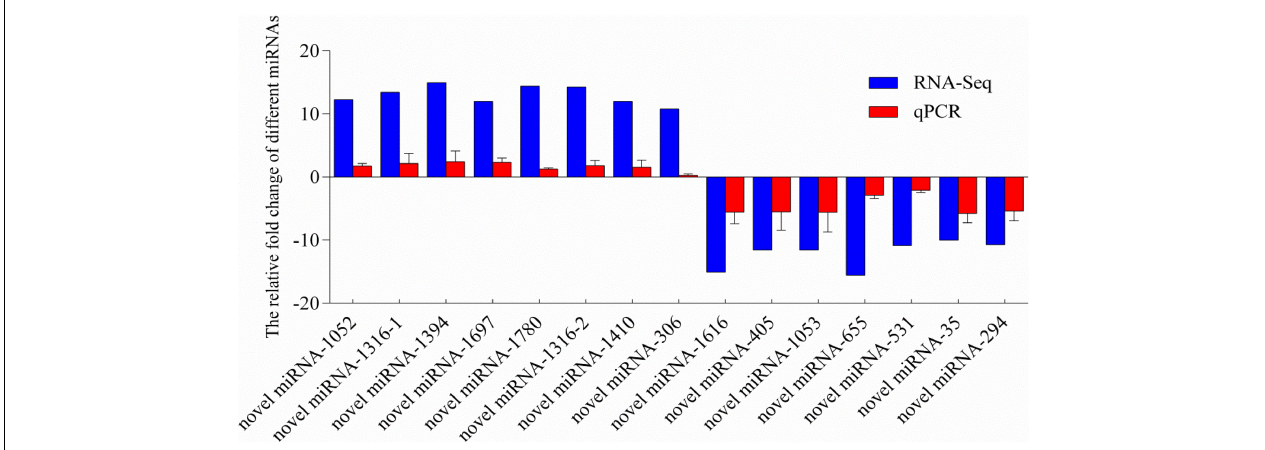
FIGURE 4 | Relative fold change of different miRNAs between qPCR and miRNA-sequencing results. MicroRNA expression levels by qPCR are presented as the fold change compared with the control after normalization against U6snRNA. Relative expression levels from the RNA-seq results were calculated as logFC values. Novel miRNA-1316 had significantly different expressions in two different groups, so we calculated the levels in two groups. (Note: the novel miRNA-1316-1 was in group C vs. S; the novel miRNA-1316-2 was in group C vs.